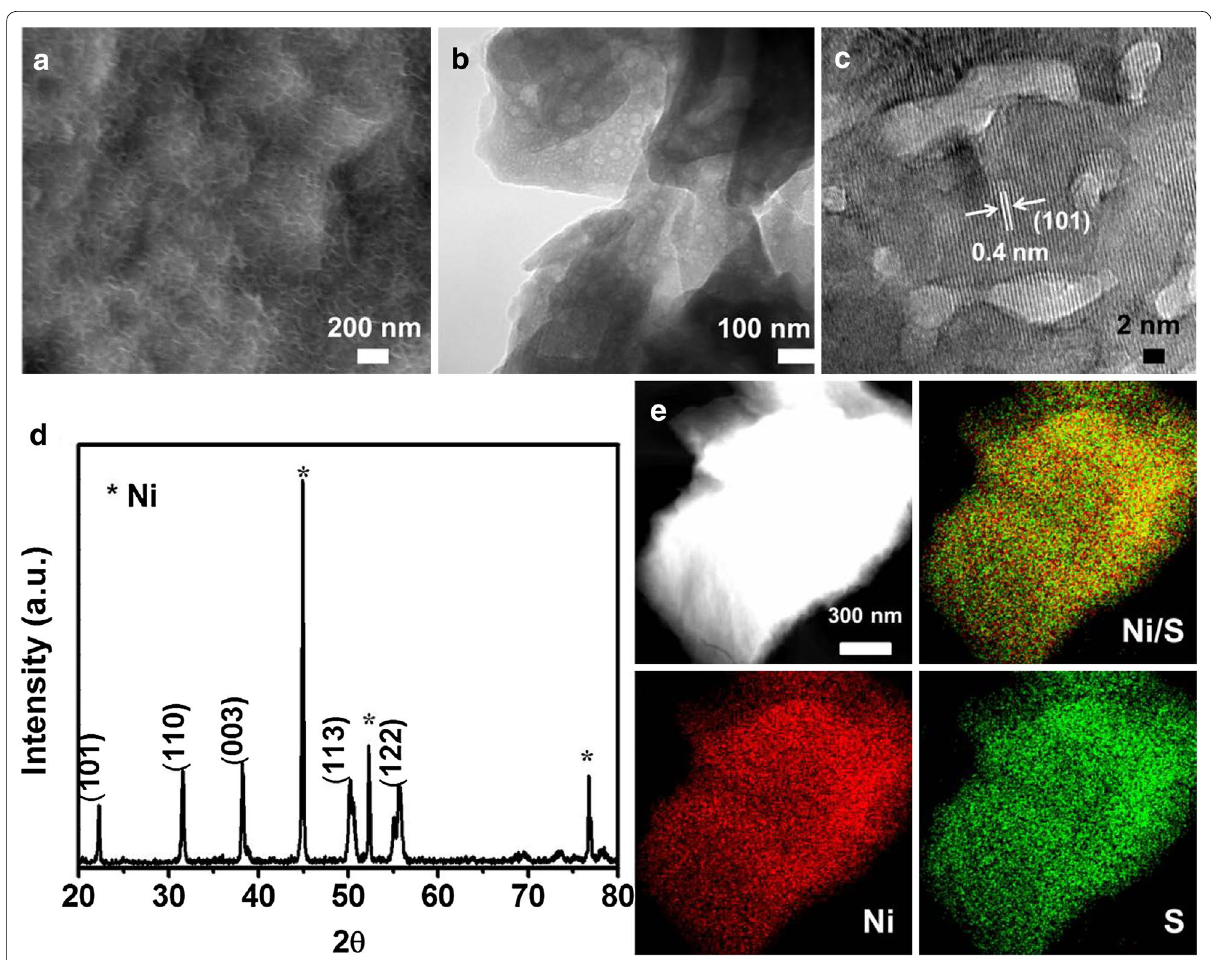
Fig. 4 a FE-SEM, b TEM, c HR-TEM images and d X-ray diffraction of HC–Ni 3 S 2 /NF. e EDS elemental mapping of HC–Ni 3 S 2 scrapped down from the Ni foam